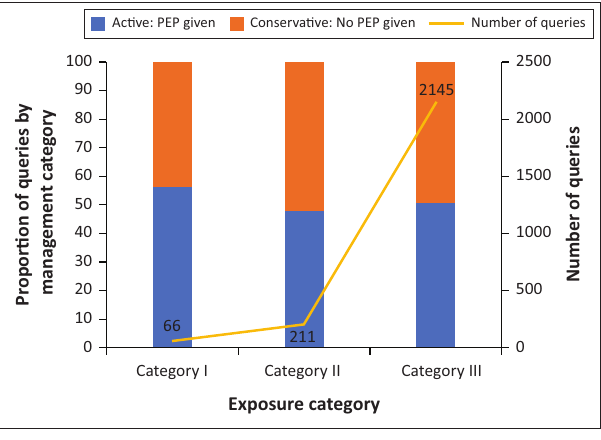
PEP, post-exposure prophylaxis. FIGURE 2: Number of queries and management advise per exposure category, 01 January 2016 to 31 December 2019.